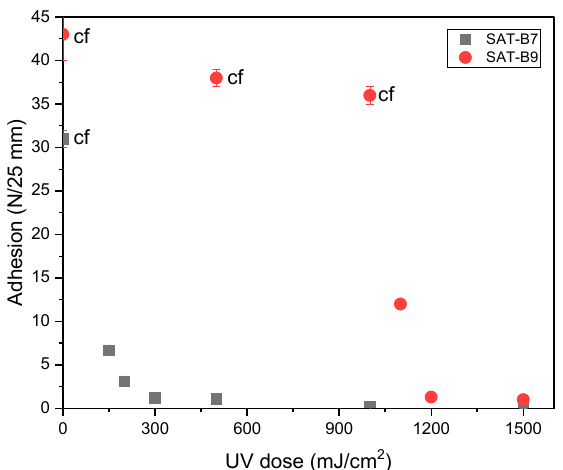
Figure 4. Adhesion to steel of SATs in relation to the UV-cross-linking dose (cf—cohesive failure). The UV-cross-linking process in SATs is possible because the EAC contains photore- active benzophenone groups (from type II photoinitiator, i.e., ABP). The mechanism of cross-linking of ABP-containing polyacrylate chains is known from the literature [38]. As can be seen, both SATs before the UV-cross-linking process show high adhesion to steel (32 N/25 mm for SAT-B7 and 43 N/25 mm for SAT-B9) but the cohesive failures effects are